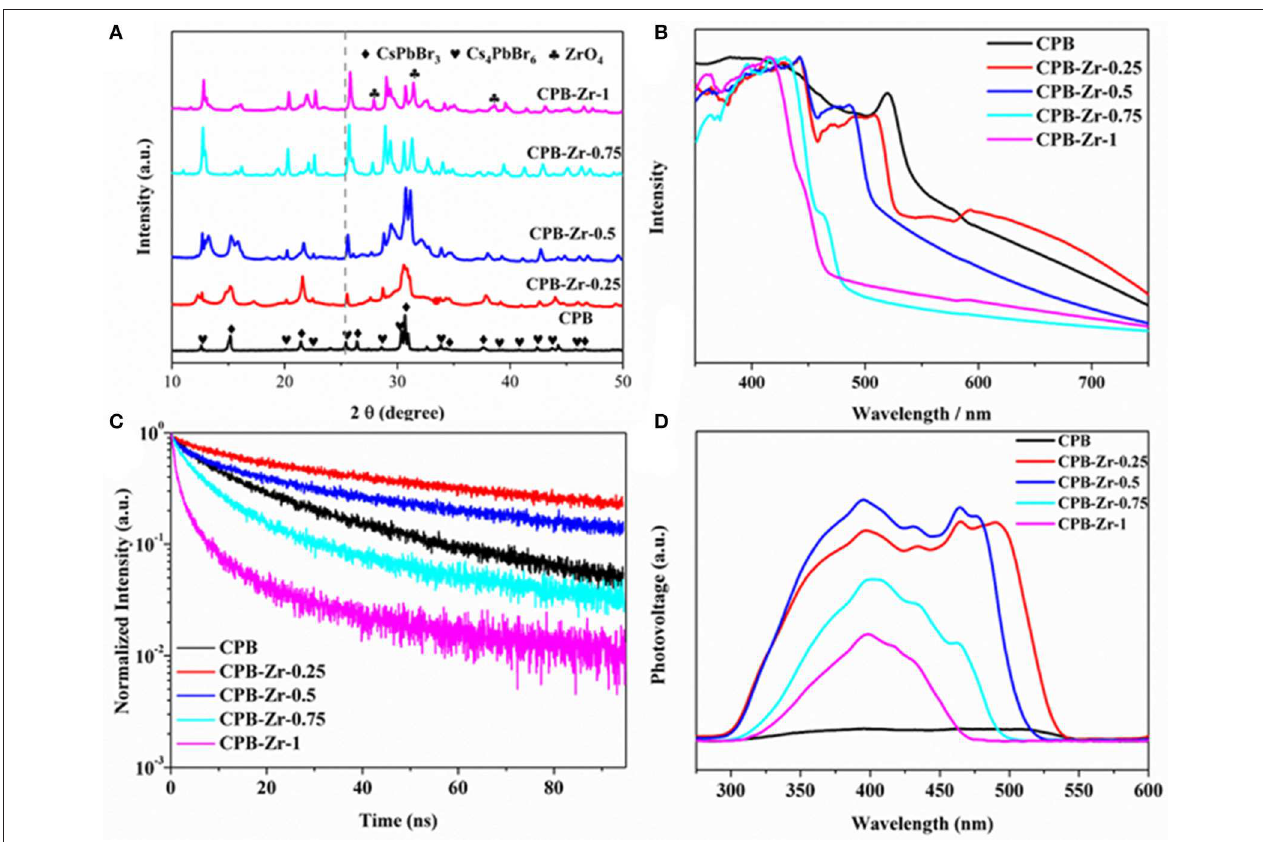
FIGURE 2 | (A) XRD patterns, (B) UV-vis diffuse reflectance spectra, (C) TRPL spectra, and (D) SPV spectra of the samples: CPB and CPB-Zr- x ( x = 0.25, 0.5, 0.75,